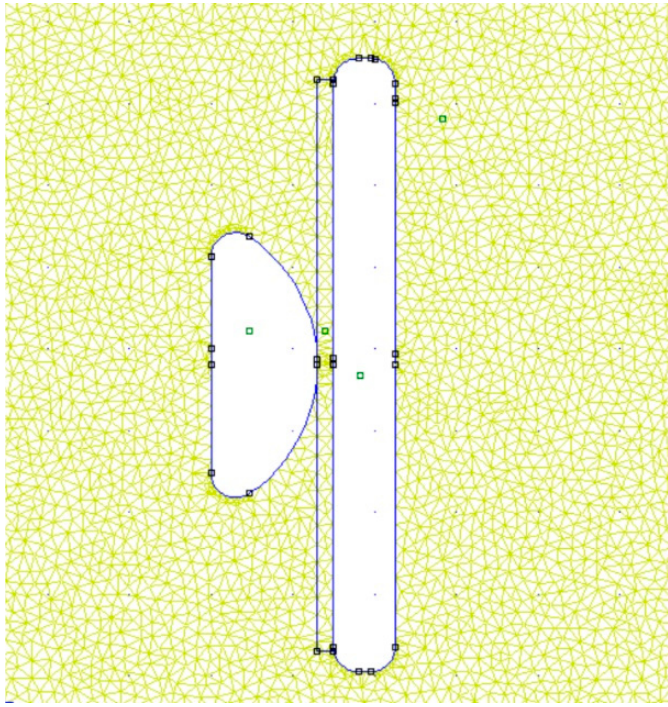
Figure 6. The model electrode system of the oil-wedge type constructed in FEMM software with applied calculating